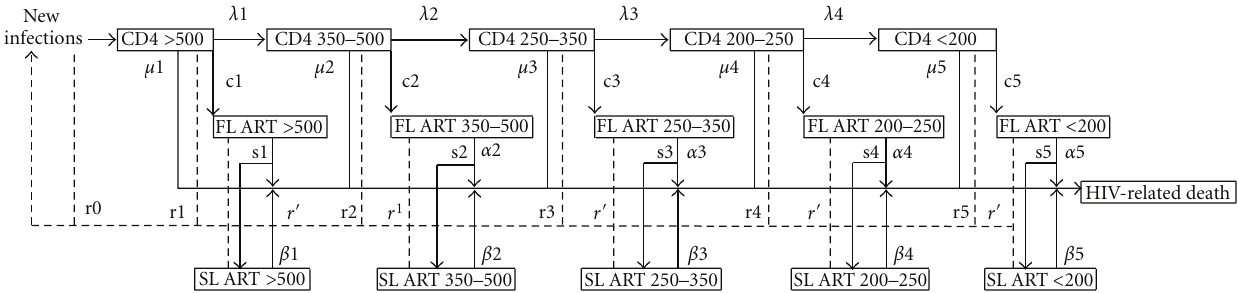
Figure 1: Model of HIV-Infected Population, Eligibility for ART and HIV-related Mortality. Notes: (1) FL ART = First line ART, SL ART = Second line ART, (2) The population receiving ART is categorized according to CD4 count at the initiation of ART, (3) The population in each box is also subject to non-AIDS mortality, and (4) Solid lines indicate flows of people, dashed lines indicate flows of information.